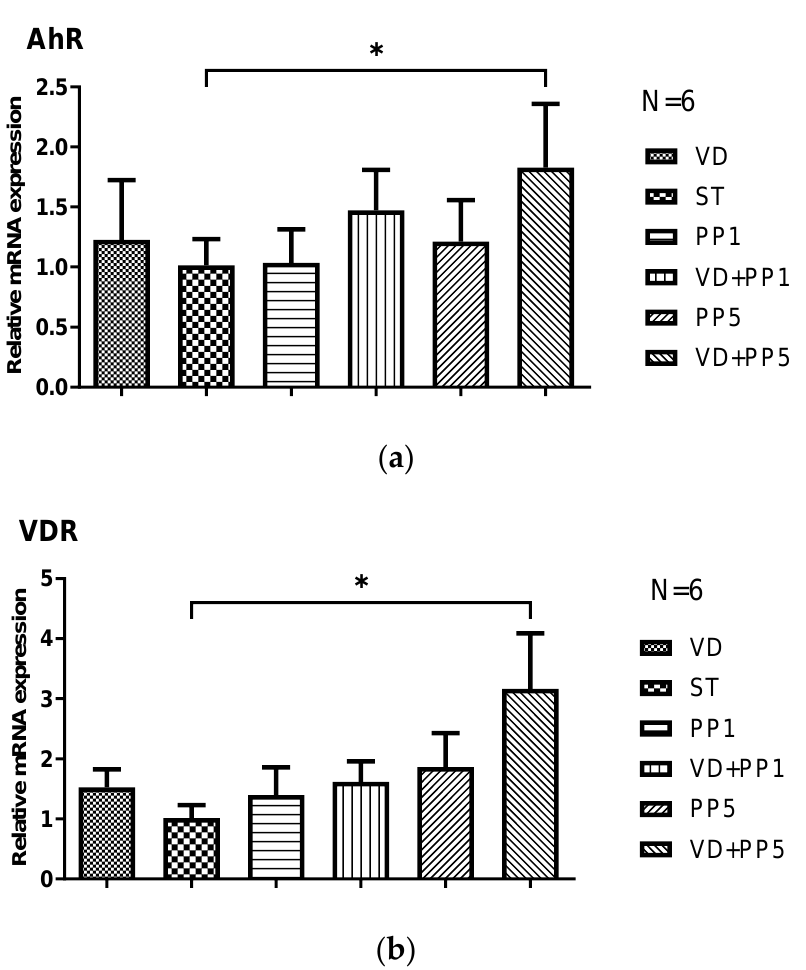
Figure 4. The synergistic effects of PP and VD3 on VDR and AhR mRNA expression in cecal mucosa of mice with Salmonella colitis. Mice were treated or infected as in Materials and Methods and divided into the following groups as above: Control, ST, VD, PP1 or PP5, VD + PP1, VD + PP5. Total RNA was extracted from the cecal tissues and quantitative RT-PCR was used to analyze the gene expression of AhR ( a ) and VDR ( b ) in the cecal tissue of infected and/or treated WT mice. Values are measured as fold increase compared to the level of control mice. The data shown are means ± SEM ( n = 6 mice/group). * p < 0.05.